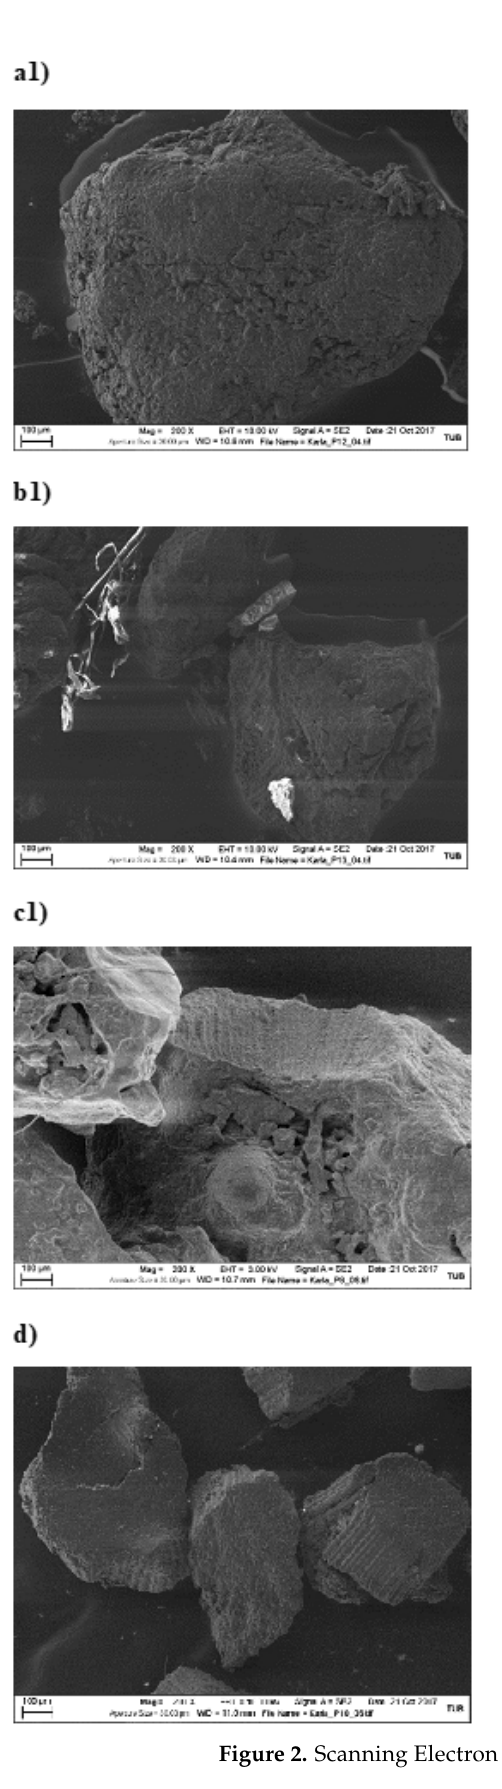
Figure 2. Scanning Electron Microscope (SEM) images of Passiflora ground seeds. ( a1 )